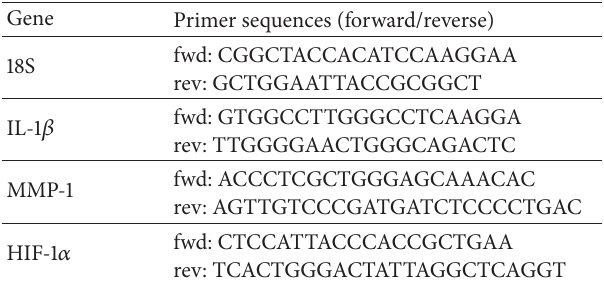
Table 1: Primer sequences used for real-time